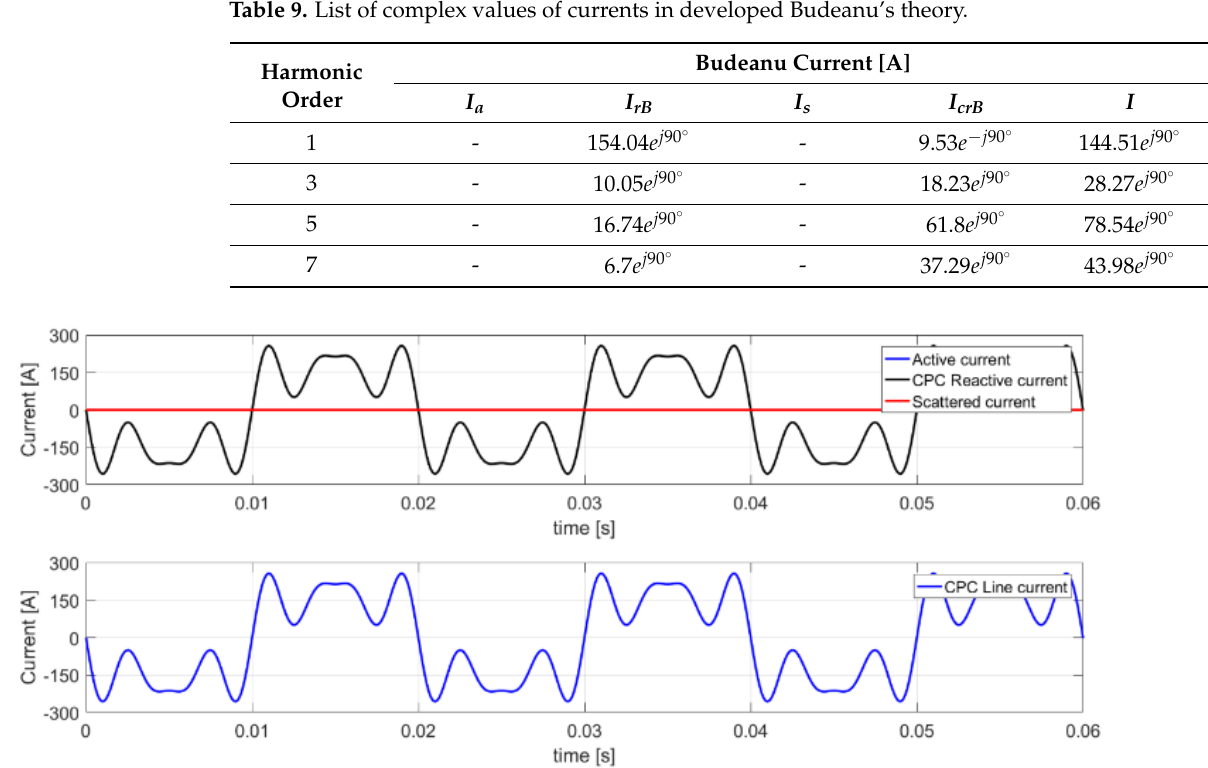
Figure 8. The waveform of the currents’ components and current of the load in CPC theory.